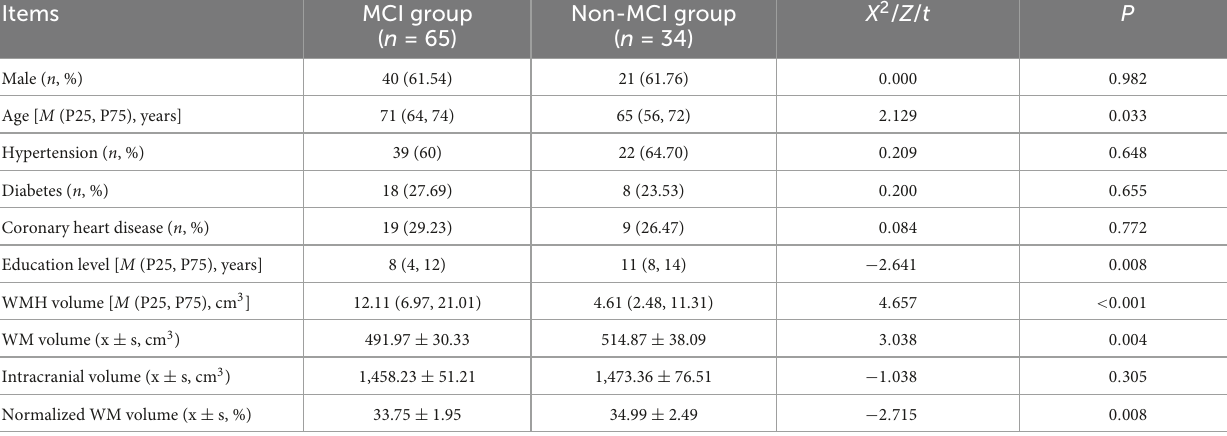
TABLE 2 Comparison of baseline data between the MCI and non-MCI groups.